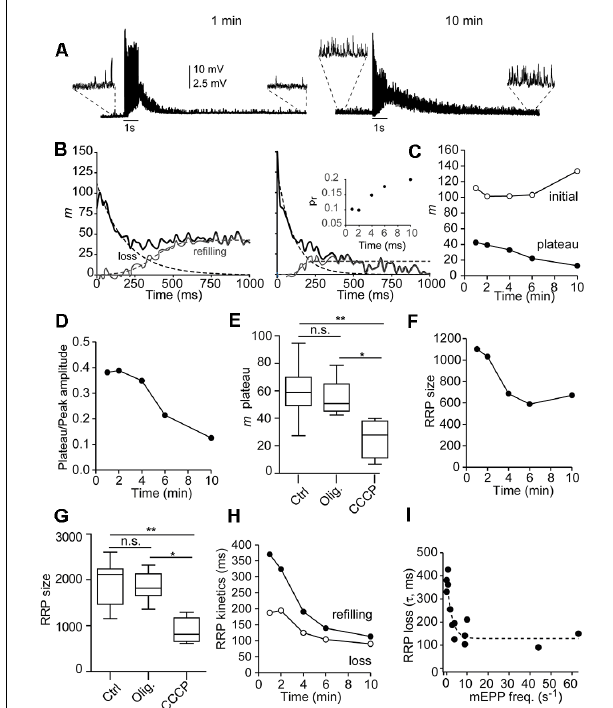
FIGURE 6 | Mitochondria modulate the depletion and refilling kinetics of the RRP and short-term plasticity during physiological stimuli. (A) Representative EPP responses of a single fiber to two 1-s stimulation trains, 1 and 10 min after adding CCCP to the recording chamber. Note the high frequency of asynchronous release before (insets), during, and after (insets) each train. (B) Curve fitting of m values during the trains (thick lines) to a function of the sum of exponential decay of the RRP plus the sigmoidal rise of recruitment (dotted lines) of the recordings in 6A for estimation of the RRP size, RRP depletion, and recruitment time. The inset on the right graph displays the probability of release ( p r ) vs. time in the CCCP, estimated by dividing the number of quanta released with the first by the size of the RRP for each train. (C) Quanta released at the initial of the train (open symbols) and plateau amplitude (filled symbols) after 1, 2, 4, 6, and 10 min in CCCP. (D) Relationship between the plateau and the initial release amplitudes with time in CCCP. (E,G) Average plateau amplitude (E) and RRP size (G) in control (10 fibers, eight mice), oligomycin alone (eight fibers, six mice), and CCCP (5–10 min, six fibers, four mice). The box-whisker plots represent median (line), 25th–75th percentile (box), and min–max (whisker) for each condition (P Kruskal-Wallis = 0.0018). *: < 0.05; **: < 0.005; n.s.: not significative. (F) Decrease of the RRP over time in CCCP (same fiber as in A ). (H) Acceleration of RRP depletion ( τ RRP , open symbols) and vesicle recruitment ( t 1/2 , filled symbols) over time in CCCP. (I) Correlation between the depletion of the RRP and the frequency of mEPP before the train. The data were fitted with an exponential function (dotted